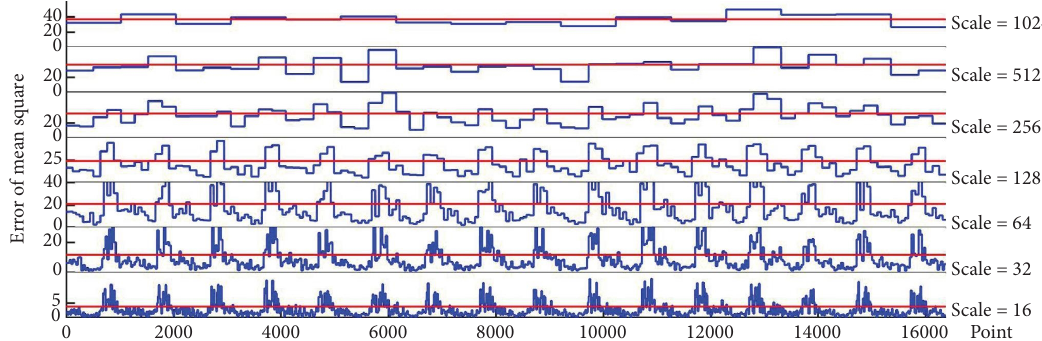
Figure 12: Mean square error at diferent scales.